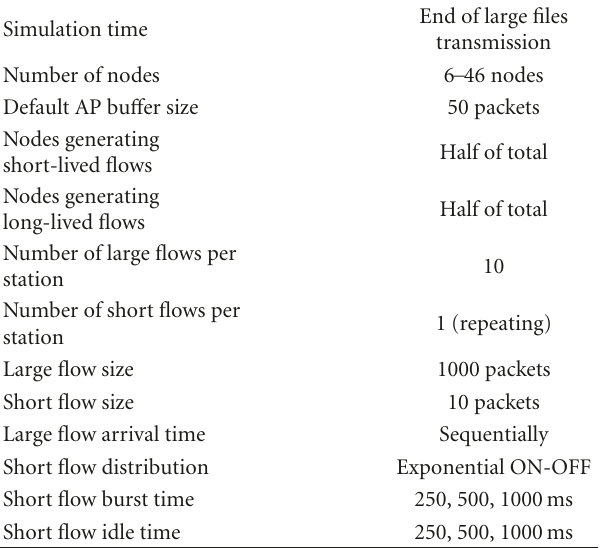
Table 3: Simulation parameters for size-based fairness evaluation.